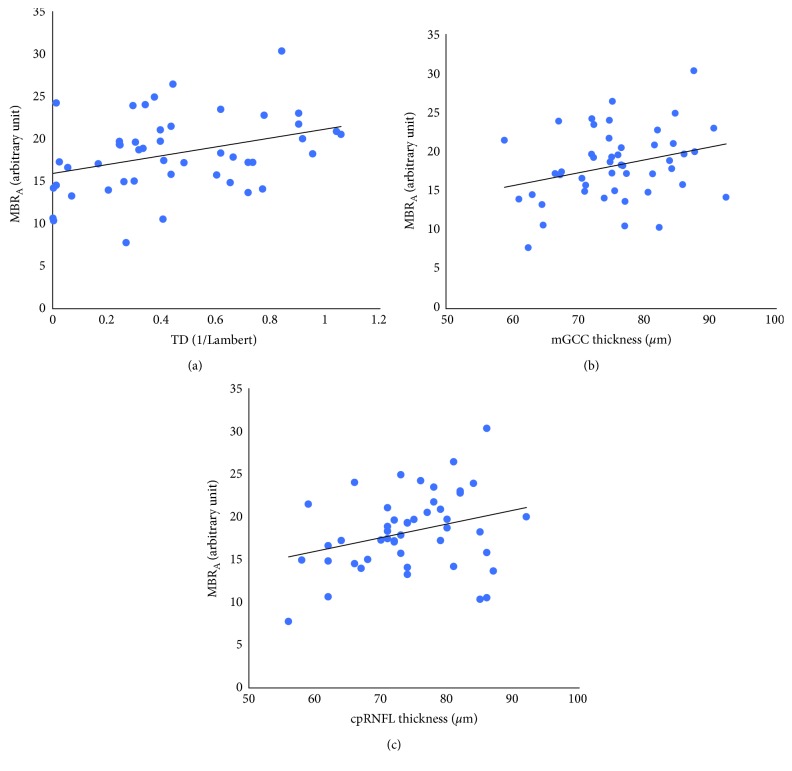
Relationships between mean blur rate in all areas (MBRA), total deviation (TD), macular ganglion cell complex (mGCC) thickness, and circumpapillary retinal nerve fiber layer (cpRNFL) thickness corresponding to the defective hemifield: (a) MBRA and TD, y = 15.984 + 5.232x (r = 0.352, P = 0.015); (b) MBRA and mGCC thickness, y = 5.796 + 0.165x (r = 0.293, P = 0.046); (c) MBRA and cpRNFL thickness y = 6.347 + 0.160x (r = 0.299, P = 0.041).